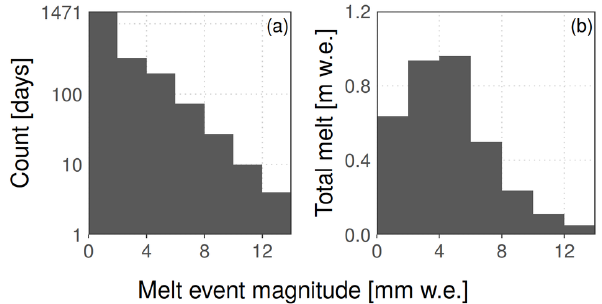
Figure 11. (a) Distribution of magnitudes of modeled melt events (defined as total daily melt amounts). The y axis is logarithmic. (b) Cumulative melt amounts sorted by the magnitude of contribut- ing melt events. Melt amount for each event is averaged over the whole domain of Fig. 8. A 20m grid resolution and 1h time step are